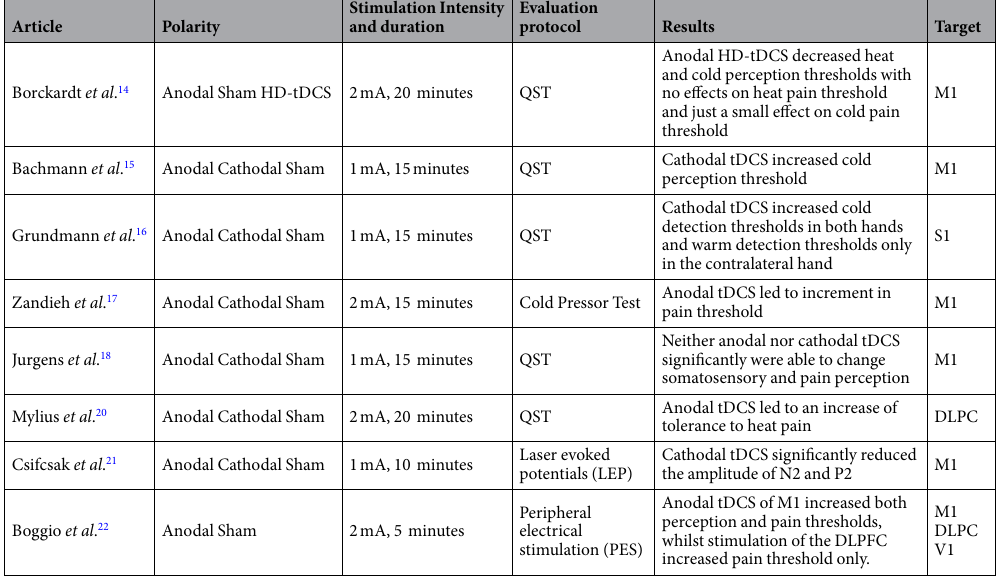
a figure-of-eight magnetic coil (diameter of one winding, 70 mm; peak magnetic field, 2.2 Tesla). The magnetic stimulus had a biphasic waveform with a pulse width of about 300 μ s. During the first phase of the stimulus, the current in the center of the coil flowed towards the handle. The coil was placed tangentially on the scalp inducing a posterior-anterior current in the brain. We determined the optimal position for activation of the right first dor- sal interosseous (FDI) by moving the coil in 0.5 cm steps around the presumed motor hand area of the left motor cortex. The site where stimuli of slightly suprathreshold intensity consistently produced the largest motor evoked potentials (MEPs) with the steepest negative slope in the target muscle was marked as the “hot spot”.